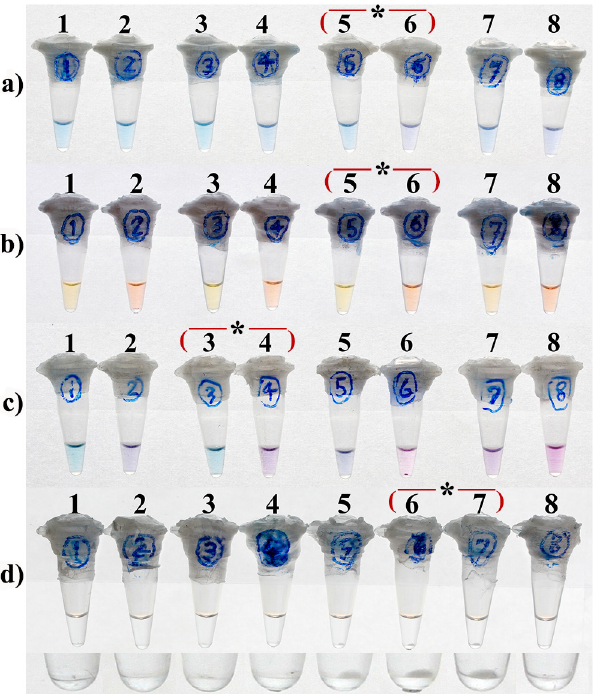
Figure 2. Optimization of Mg 2+ concentration in HNB-LAMP ( a ), Calcein-LAMP ( b ), EBT-LAMP ( c ), and turbidity-LAMP ( d ) for the detection of M. tuberculosis . ( a , c ) 2.5 mM (tubes 1 and 2), 3.5 mM (tubes 3 and 4), 4.5 mM (tubes 5 and 6), and 5.5 mM (tubes 7 and 8) MgSO 4 . ( b ) 4 mM (tubes 1 and 2), 6 mM (tubes 3 and 4), 8 mM (tubes 5 and 6), and 10 mM (tubes 7 and 8) MgSO 4 . Tubes with even and odd numbers, respectively, represent negative and positive reactions. In ( d ), tubes 1 to 7 are positive reactions, respectively, containing 2, 3, 4, 5, 6, 8, and 10 mM MgSO 4 , and tube 8 is the negative control. The image on the bottom shows the close-up view of ( d ) focused on the pellets of pyrophosphate magnesium. The asterisks indicate the optimal concentration of Mg 2+ .